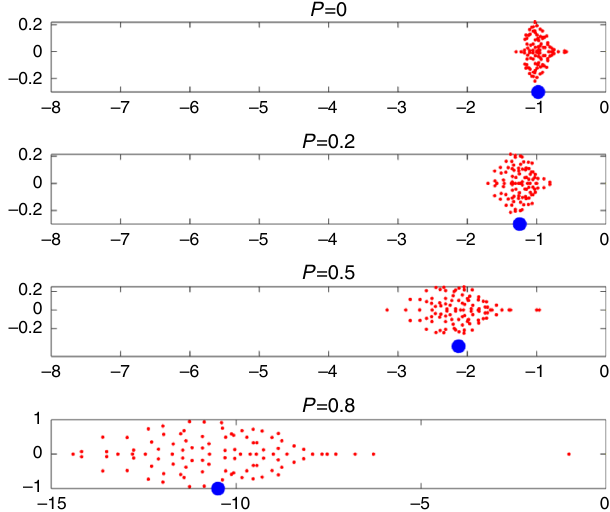
of the Jacobian or Fig. 3 Eigenvalue distributions. Eigenvalues λ i community matrix in the complex plane, for four different values of P . Imaginary parts Im( λ i ) versus real parts Re( λ i ) are plotted. The “ bulk ” eigenvalues (red dots) are contained in an ellipse which centers close to the mean equilibrium level, i.e., (cid:2) N * plotted as blue circles. Stability becomes i stronger (ellipse shifts to the left) as the proportion P of mutualistic interactions increases in otherwise exploitative communities. When P > 0.4, the largest outlier eigenvalue is Λ ¼ (cid:2) 1 (see Eq. (2)). For P = 0.8, it was necessary to stretch the scale for the x -axis and it is different to the other panels. Parameters: n = 100 species; interaction variability σ = 0.02; connectance C = 0.7; growth rates r 1, as in Fig. 2. i ¼